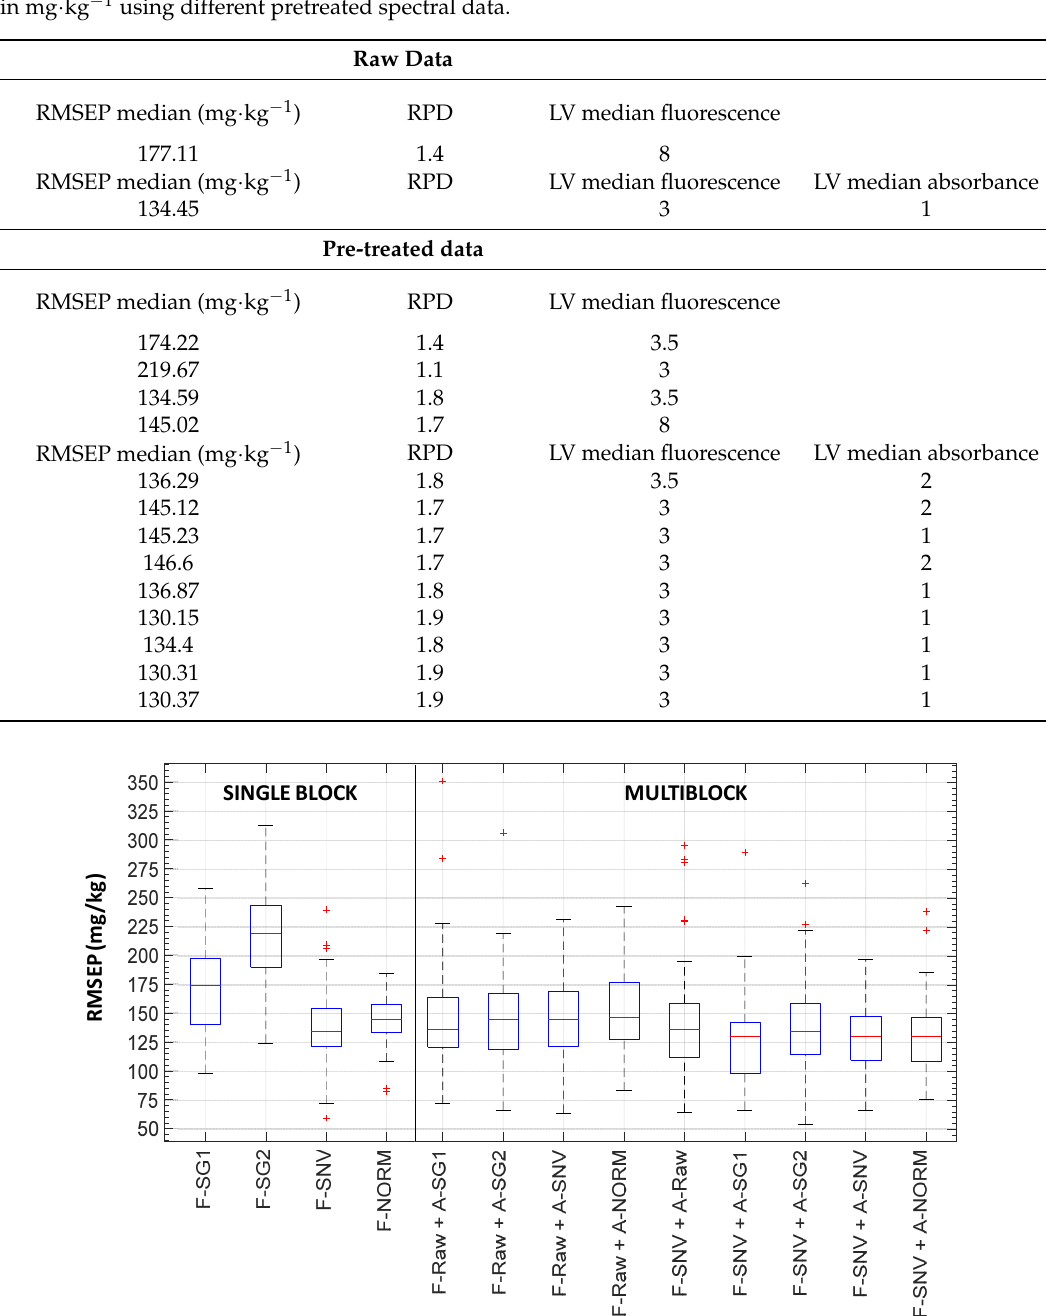
Figure 5. RMSEP boxplots of 50 iterations of the double cross-validation for models including pre- treated data. Bottom and top edges of the blue box are the 25th and 75th percentiles, respectively; the central mark is the median; whiskers extend to the most extreme data points not considered outliers; the ‘+’ symbol plots outliers.